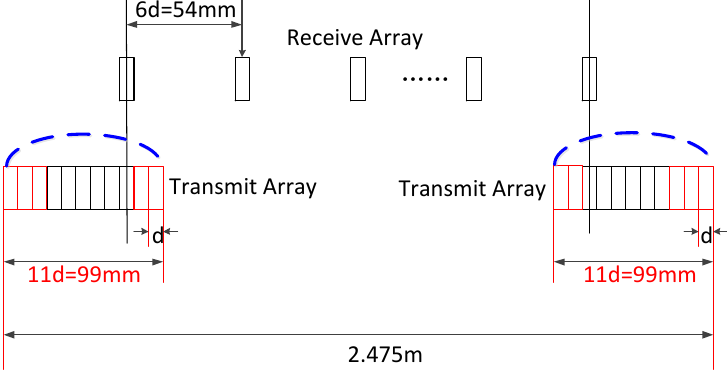
Figure 15. MIMO array with low grating lobes in near-field area.